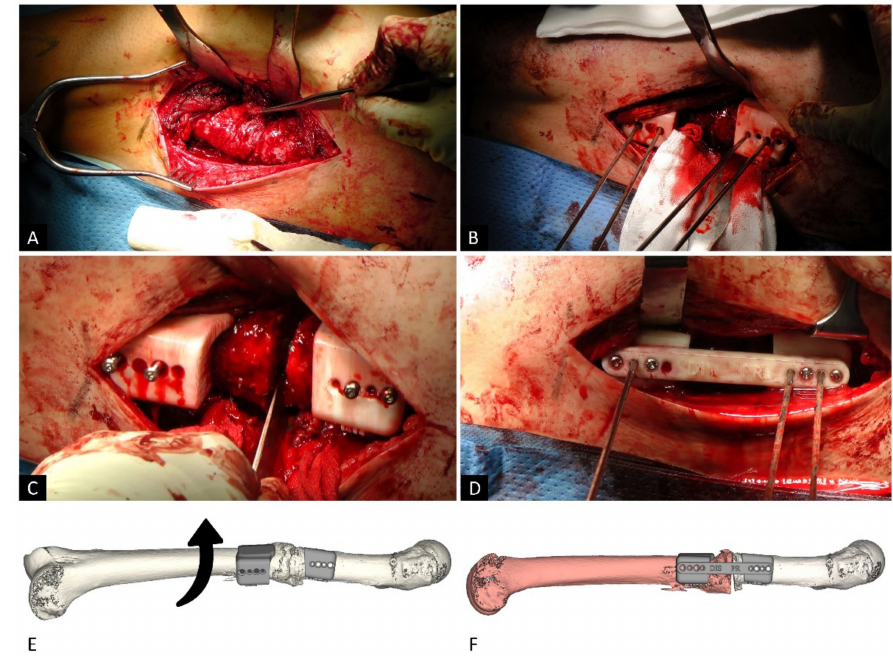
Figure 2. Surgical technique (Patient 3). After exposing the femoral diaphysis through a postero-lateral approach ( A ), the two initial surgical guides are pinned to the bone surface ( B ). Subsequently, the osteotomy is carried out by removing all previous osteosynthesis material ( C ). The correction is performed with an external or internal rotation of the distal femoral fragment and the third 3D- printed guide is used to connect the other two, providing the correct femoral rotation degree ( D ). The degrees of rotation of the distal femoral fragment are defined by the alignment of the two guides ( E ). Once the two guides are aligned and connected by the third piece, the distal fragment is already correctly rotated according to the surgical planning ( F ). Finally, the osteotomy is completed by inserting the intramedullary nail and removing the surgical